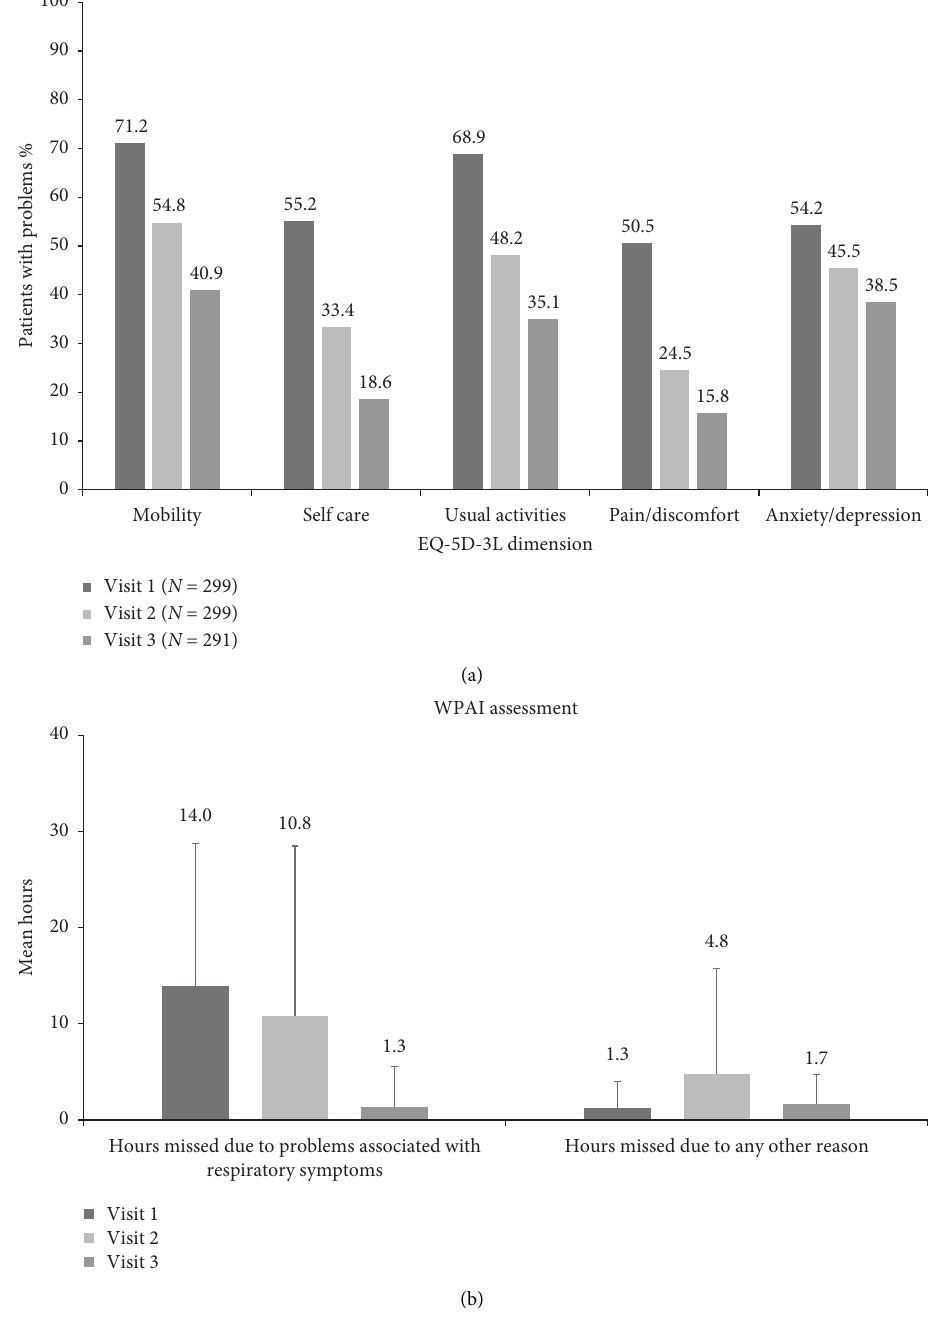
Figure 4: Patients’ quality of life and work productivity improvement at baseline (visit 1) and postbaseline visits. (a) Patients with problems in the EQ-5D-3L dimensions mobility, self-care, usual activities, pain/discomfort, and anxiety/depression at baseline, visit 2, and visit 3. (b) Mean hours missed from work due to respiratory and other problems at baseline, visit 2, and visit